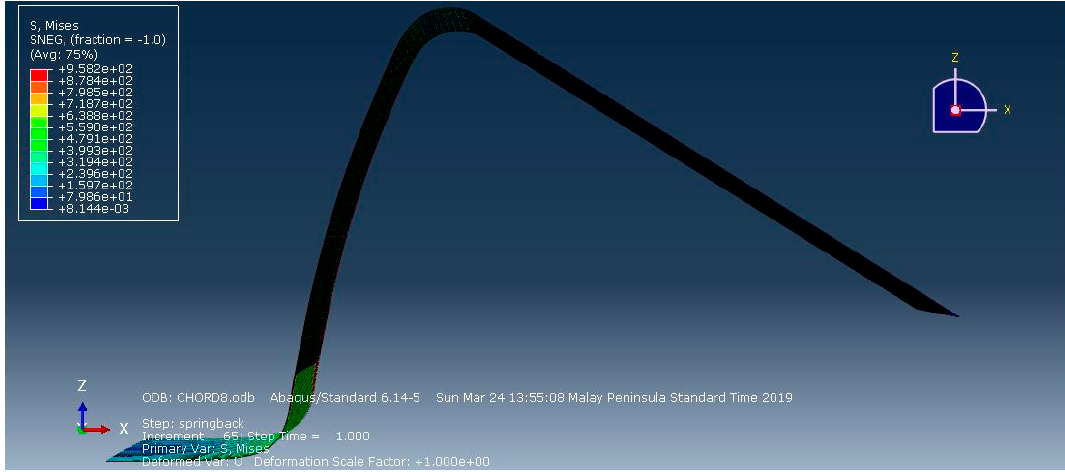
Figure 6. Springback simulation for 25% of stress forward. Table 2. Measurement of the parameters and errors of springback simulation.